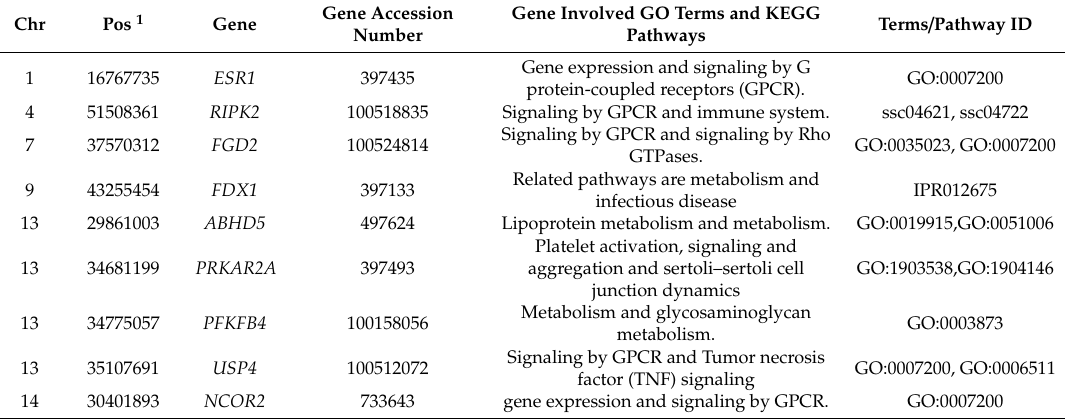
Table 1. The nine identified SNPs with He = 1 and their related functional genes and Gene ontology (GO) terms and Kyoto Encyclopedia of Genes and Genomes (KEGG)